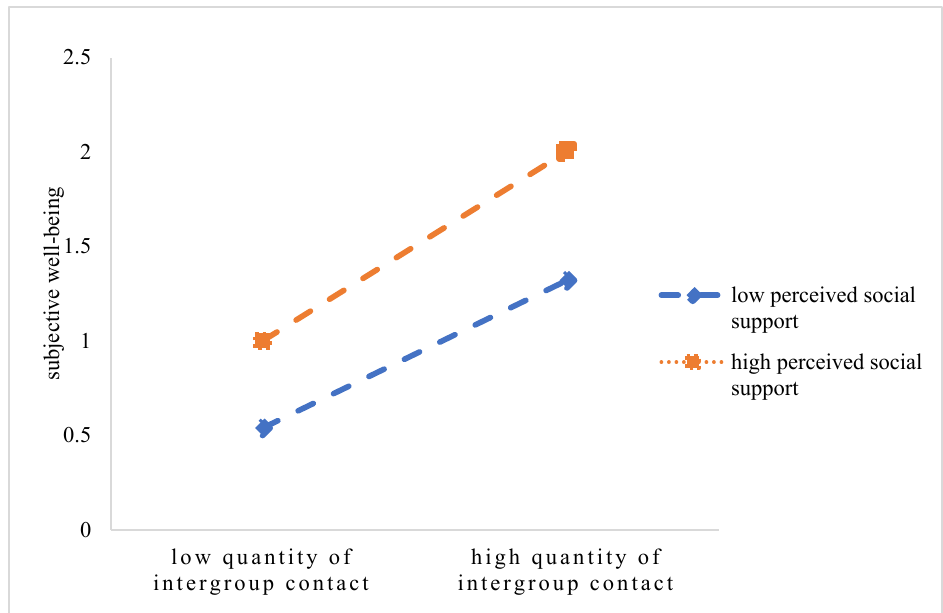
Figure 1. The interaction effects of quantity of intergroup contact and social support on subjective well-being.